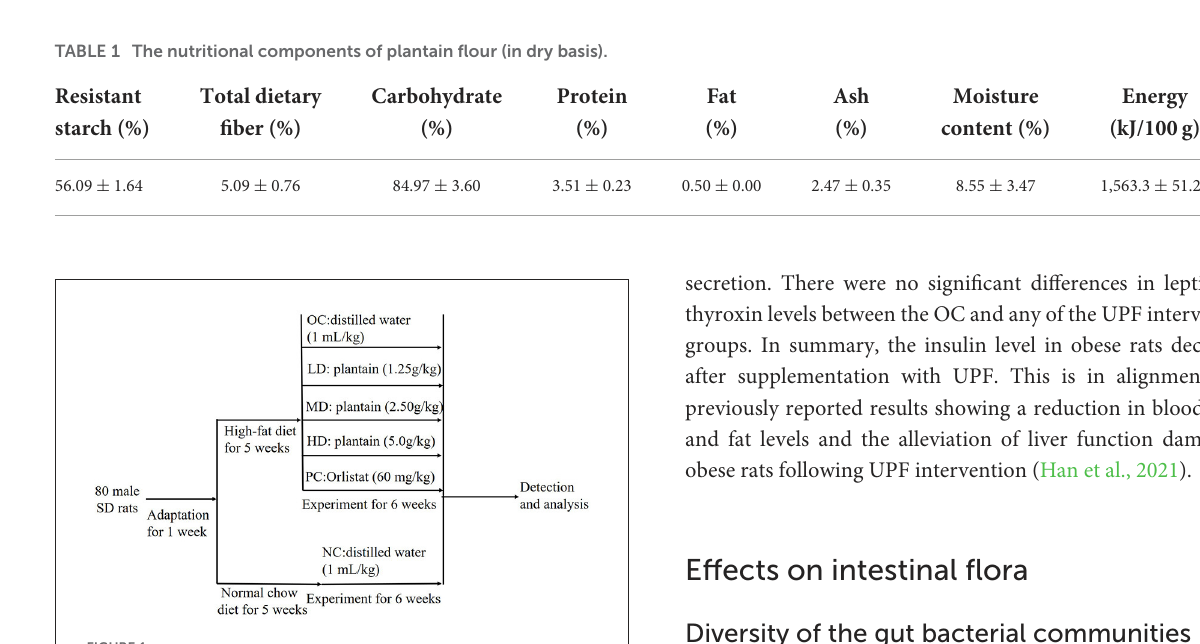
FIGURE1 The protocol and design of animal experimental. NC, Normal control group; OC, Obesity control group; LD, Low-dose group; MD, Intermediate-dose group; HD, High-dose group; PC, Positive control